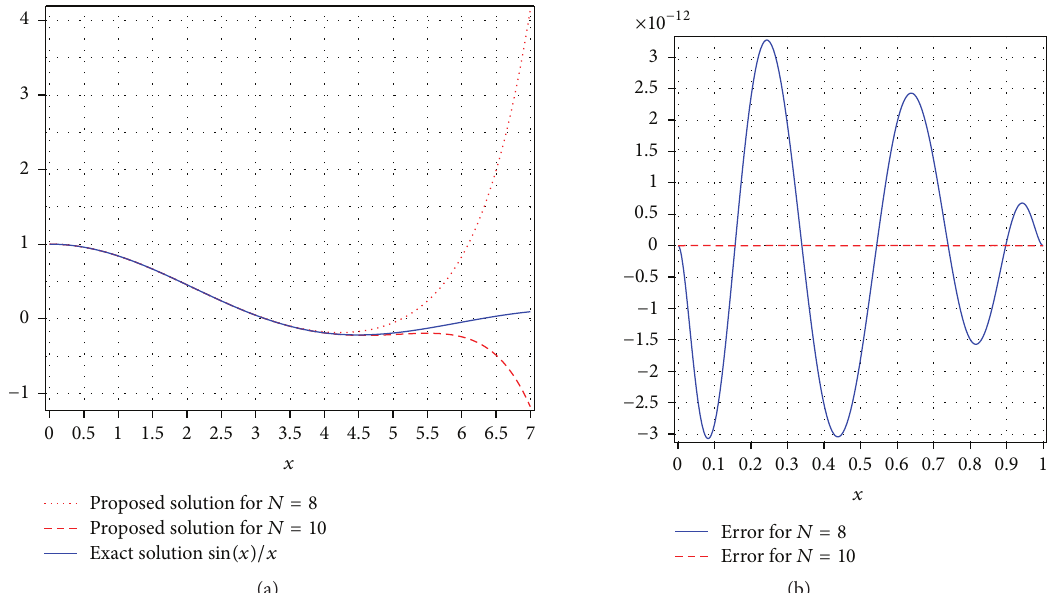
Figure 1: (a) Comparison of the exact and approximated solutions and (b) history of the